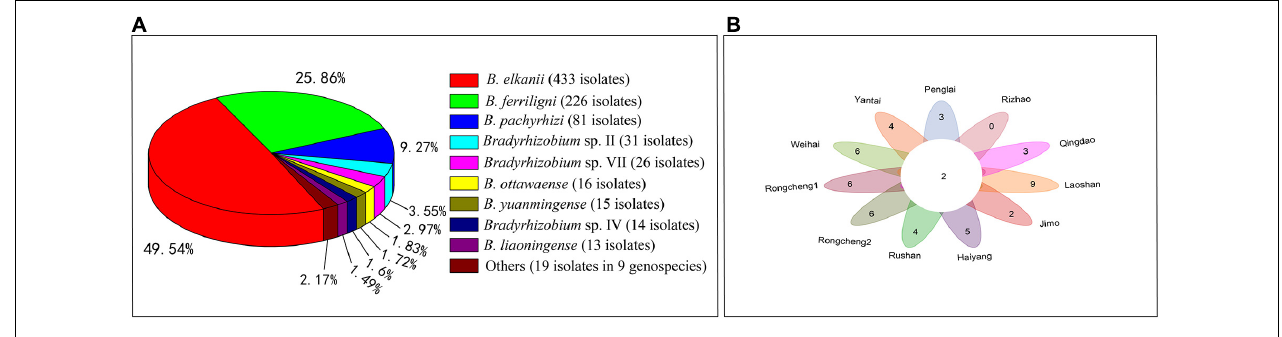
FIGURE 3 | The statistical data of V. minima -nodulating rhizobia isolated in this study. (A) The diagram showing the relative percentage abundances of the genospecies nodulating with V. minima . The genospecies ratio accounting more than 1% was provided. (B) All the sampling sites commonly shared two genospecies (the number in the center circle) of B. elkanii and B. pachyrhizi . The numbers in each part of the flower indicate the remaining genospecies number subtracted from the commonly shared